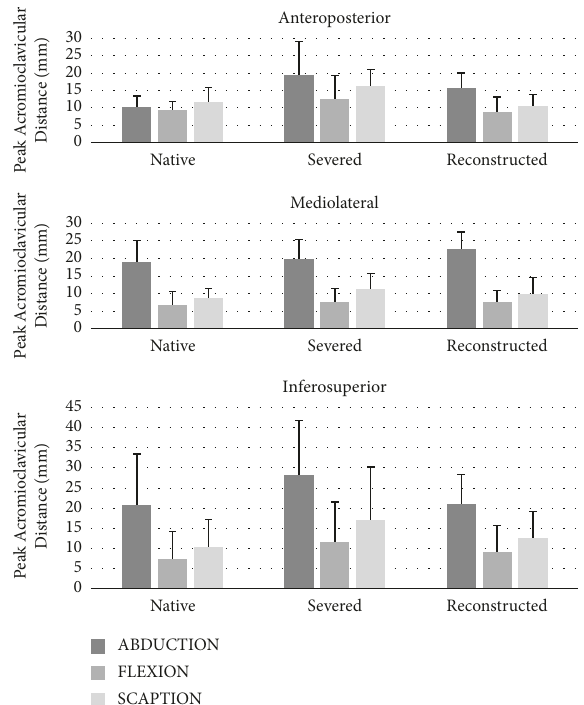
Figure 5: Biomechanical testing of peak acromioclavicular sepa- ration distance in anteroposterior, mediolateral, and inferosuperior directions during shoulder abduction, flexion, and scaption for native, severed, and reconstructed states. No significant differences were found in peak acromioclavicular distance among native, severed, and reconstructed conditions during the three movements and three directions.